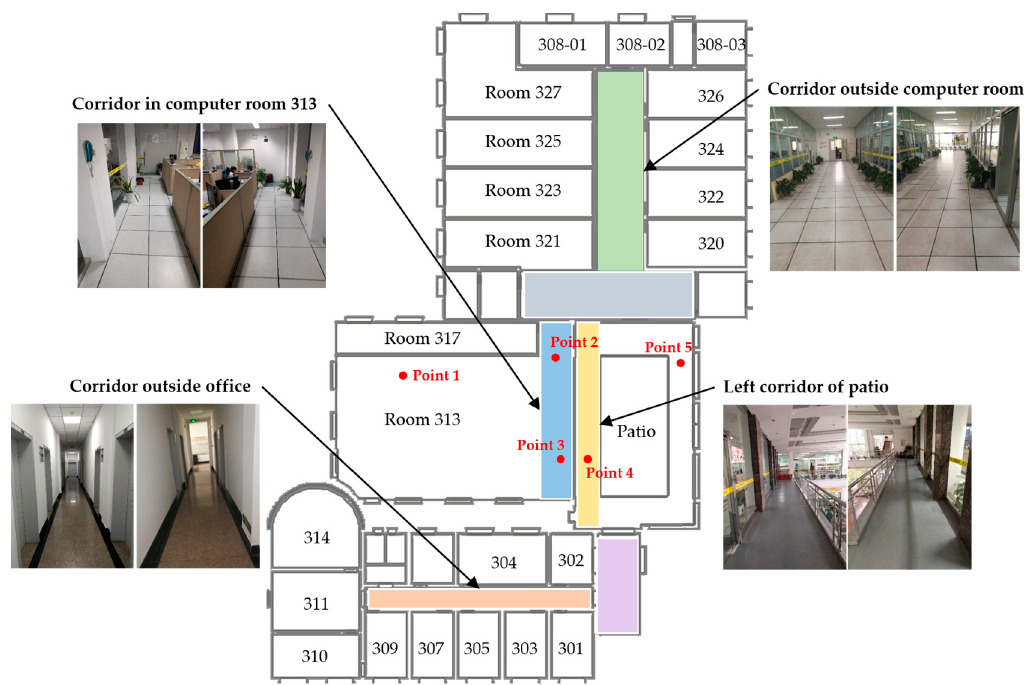
Figure 4. Examples of indoor scenes on the third floor of our laboratory. Two images are given in different walking directions.